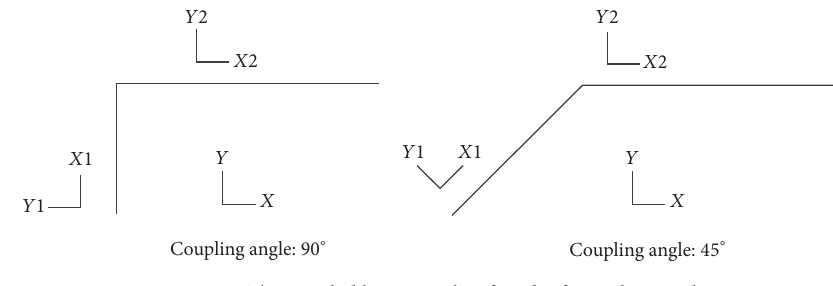
Figure 4: The coupled beams with 90 ∘ and 45 ∘ coupling angle. Table 5: Four cases of coupling condition for coupled beams.